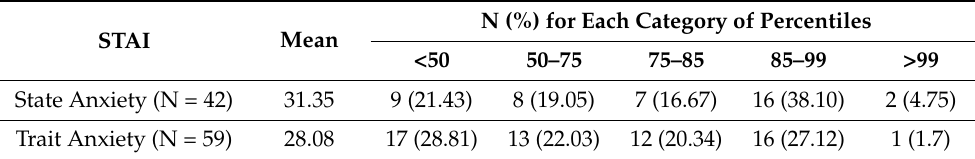
Table 4. Sample means and percentages of the STAI questionnaire.